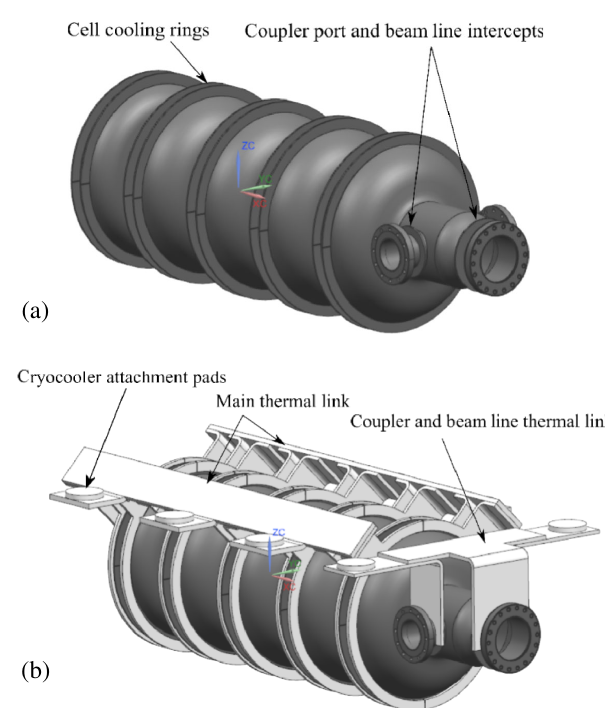
FIG. 20. (a) Rendering of the five-cell cavity with e -beam welded cooling rings and (b) thermal links attached to the five- cell cavity by